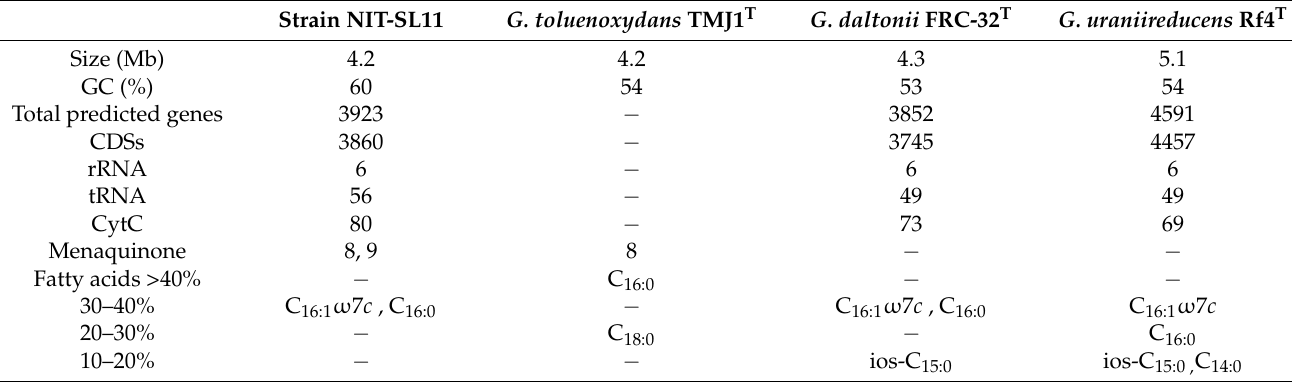
Table 2. Comparison of chemotaxonomic and genomic properties of strain NIT-SL11 and recognized species of the genus Geotalea